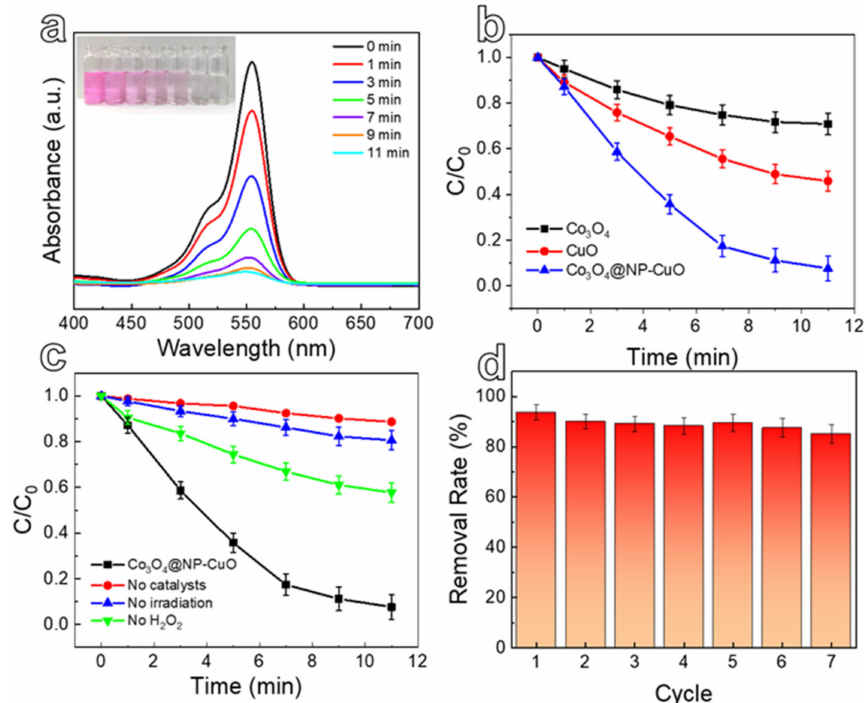
Figure 6. ( a ) UV-visible absorption spectra of RhB by the Co 3 O 4 @NP-CuO composite in the presence of H 2 O 2 for different times; ( b ) degradation performance of the Co 3 O 4 @NP-CuO composite, com- mercial CuO, and Co 3 O 4 powders; ( c ) effects of different conditions on degradation of RhB; ( d ) cyclic stability of Co 3 O 4 @NP-CuO